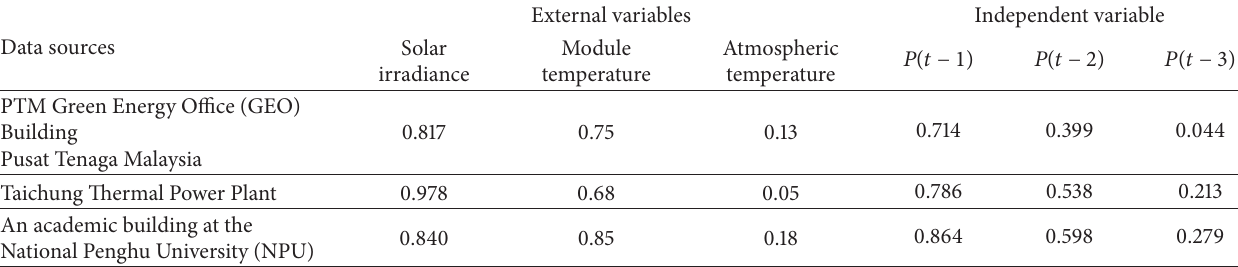
Table 2: Comparative analysis on correlation coefficients between PV generation and external